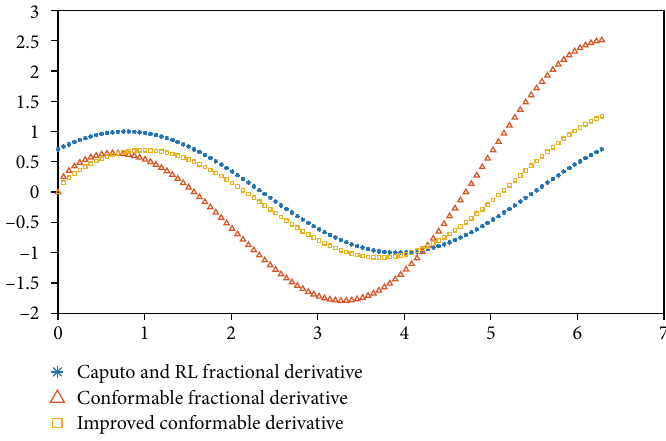
Figure 7: 0.5th fractional derivative of y = sin x .